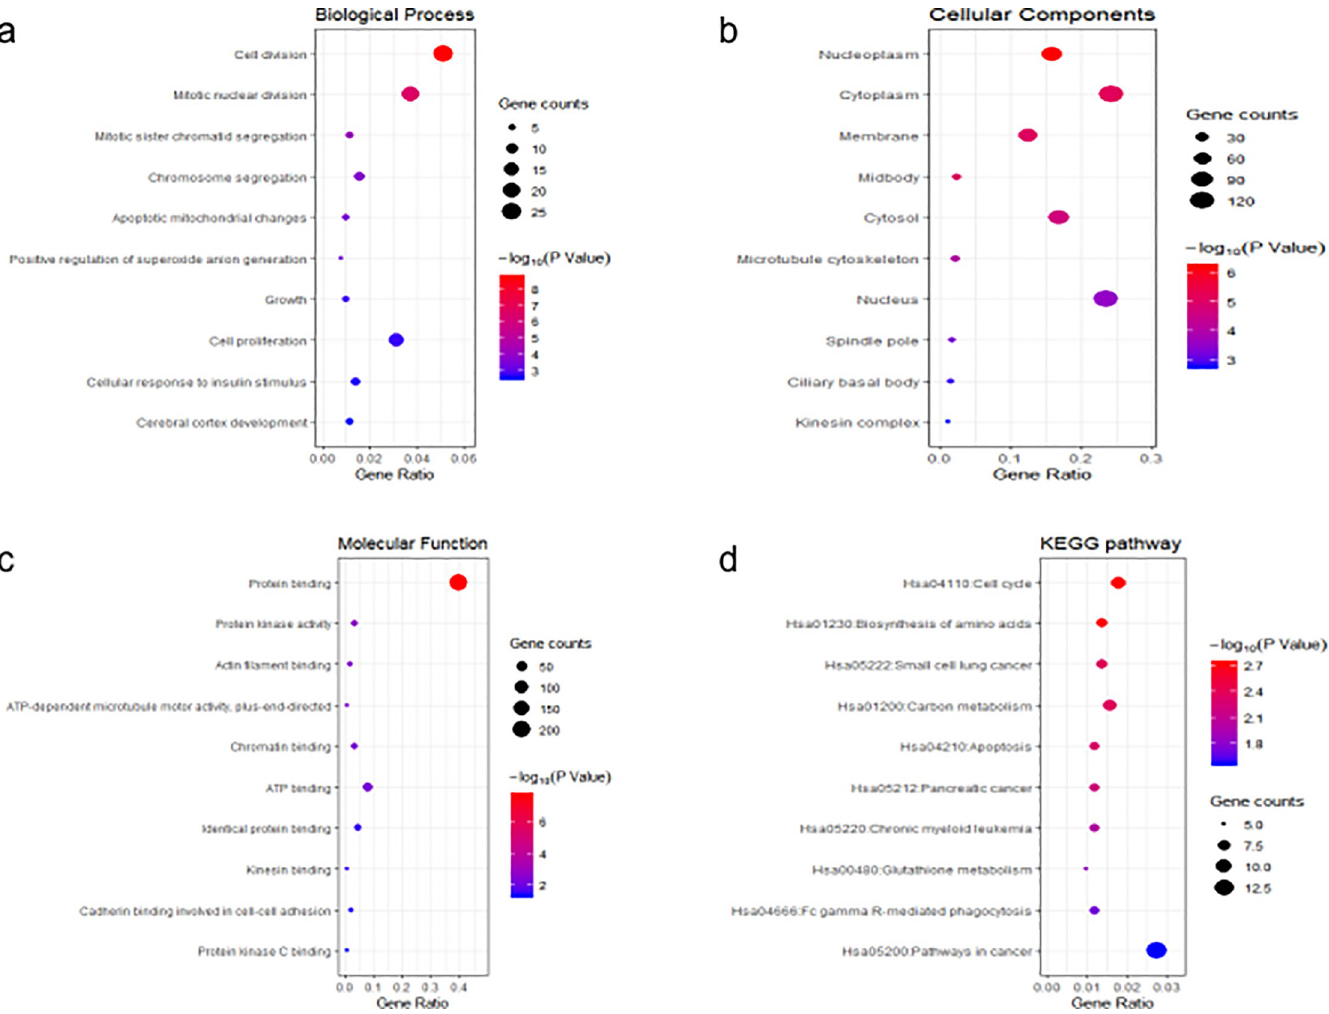
Fig 2. GO analysis and KEGG pathway analysis of the overlapping DEGs. (a) Top 10 of biological process. (b) Top 10 of cellular component. (c) Top 10 of molecular function. (d) Top 10 of KEGG pathway